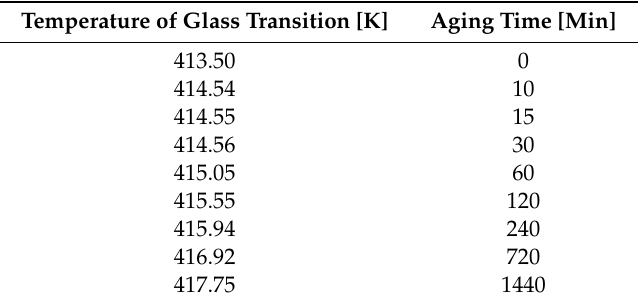
Table 2. Dependence of glass transition temperature on an aging time of the amorphous poly( N - isopropylacrylamide) obtained based on reversing heat capacity under the isothermal aging process measured by TMDSC (see Figure 13a).